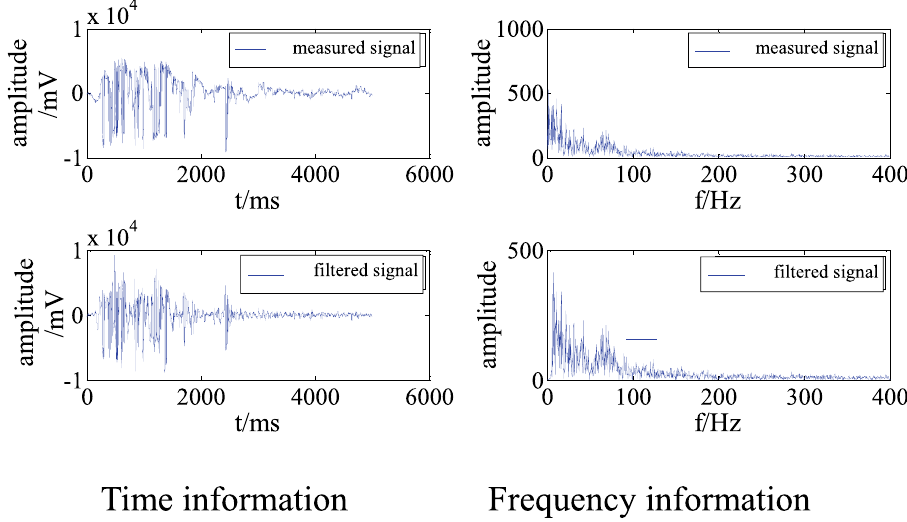
Figure 8. Time and frequency information for channel 01 before and after filtering.